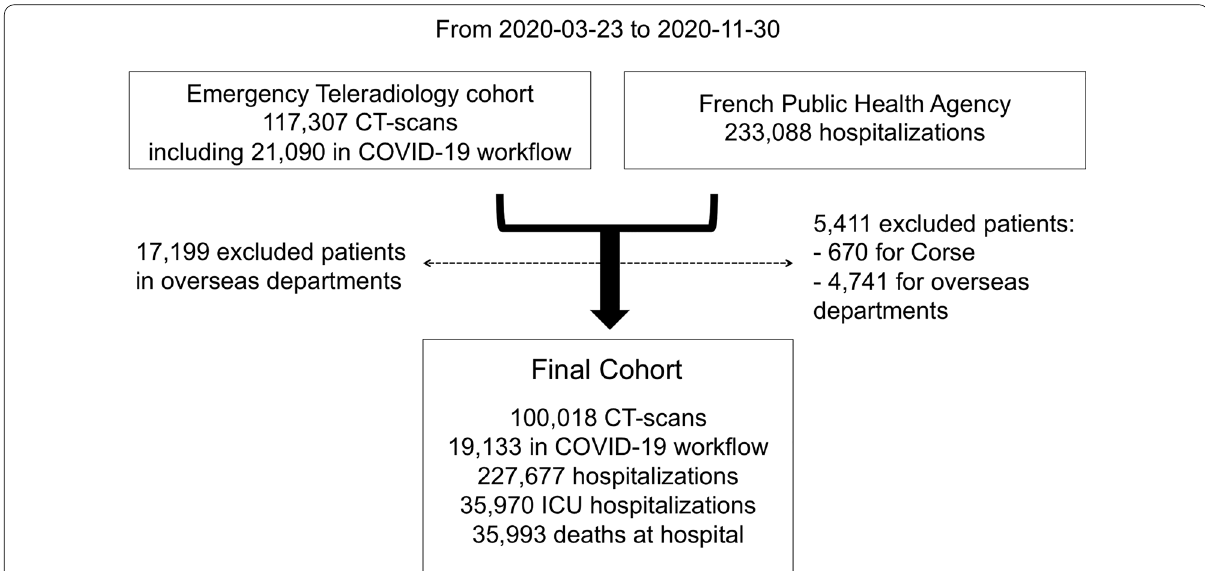
Fig. 1 Study flow chart. Abbreviation: ICU: intensive care units. The data from the French public health agency (Santé Publique France) can be found at https:// www. data. gouv. fr/ fr/ datas ets/ donne es‑ hospi talie res‑ relat ives‑a‑ lepid emie‑ de‑ covid‑